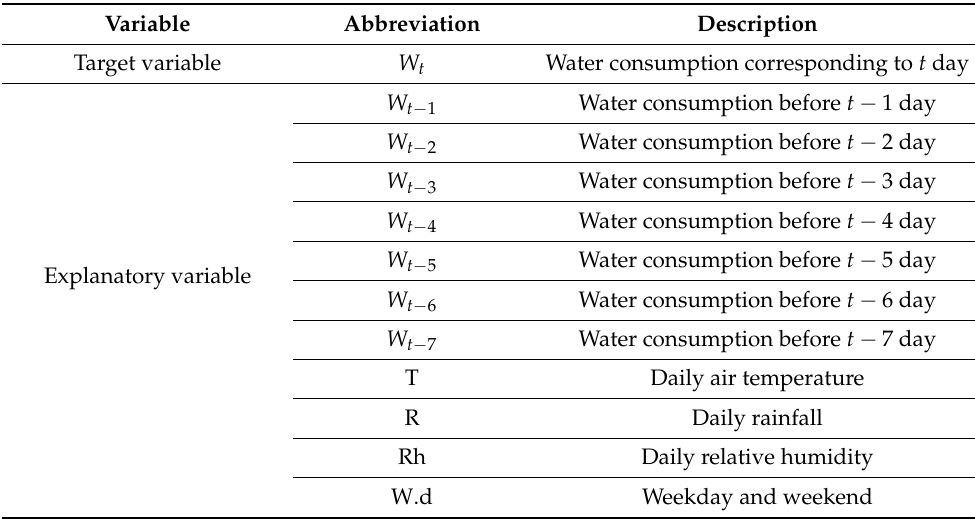
Table 4. Description of the target and explanatory